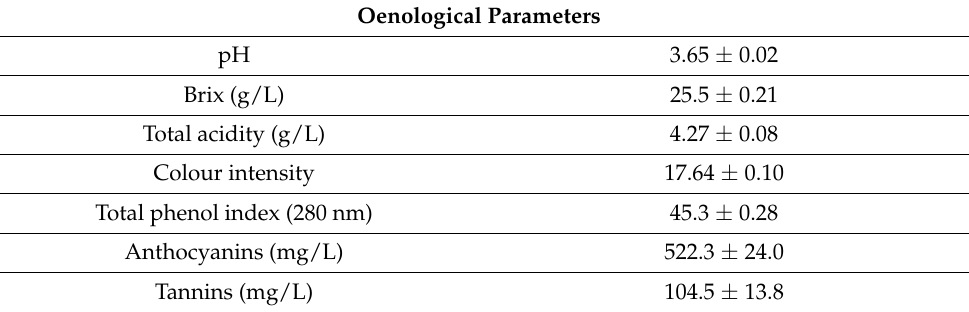
Table 1. Oenological parameters of the Grenache must after 24 h of maceration at 5 ◦ C with grapes treated by